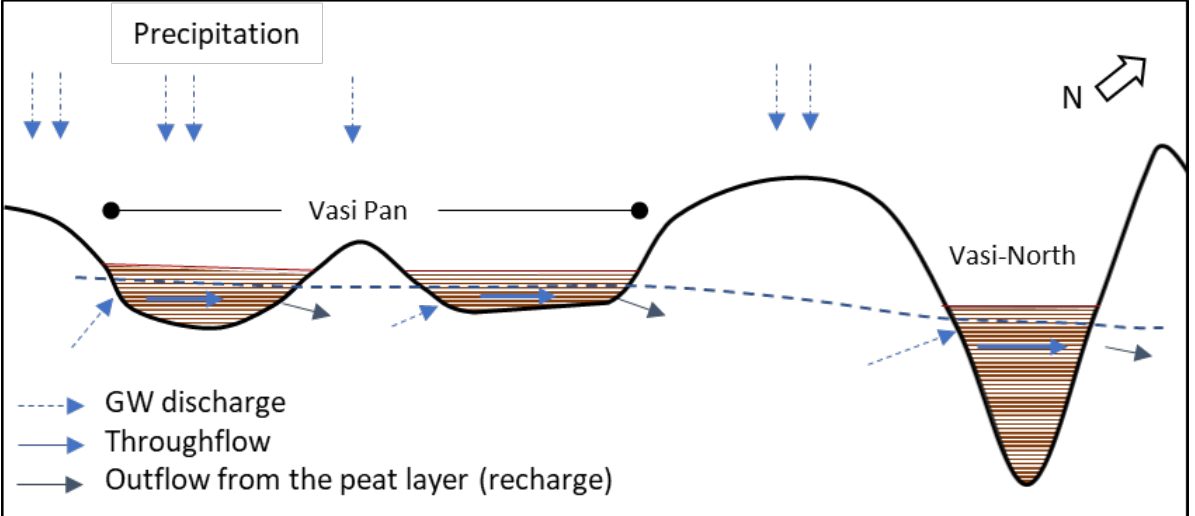
Figure 10. Conceptual model of the hydrological system of the Vasi peatland complex. Dashed blue lines represent discharge of groundwater (inflow), light blue lines indicate hypothetical throughflow within the peatland, and dark blue lines represent recharge from the peat (outflow) into the adjacent dune at the opposite side of the